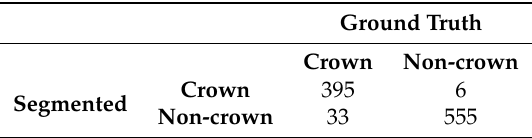
Table 5. Confusion matrix obtained from Mask R-CNN tree crown detection using the algorithm evaluation dataset.